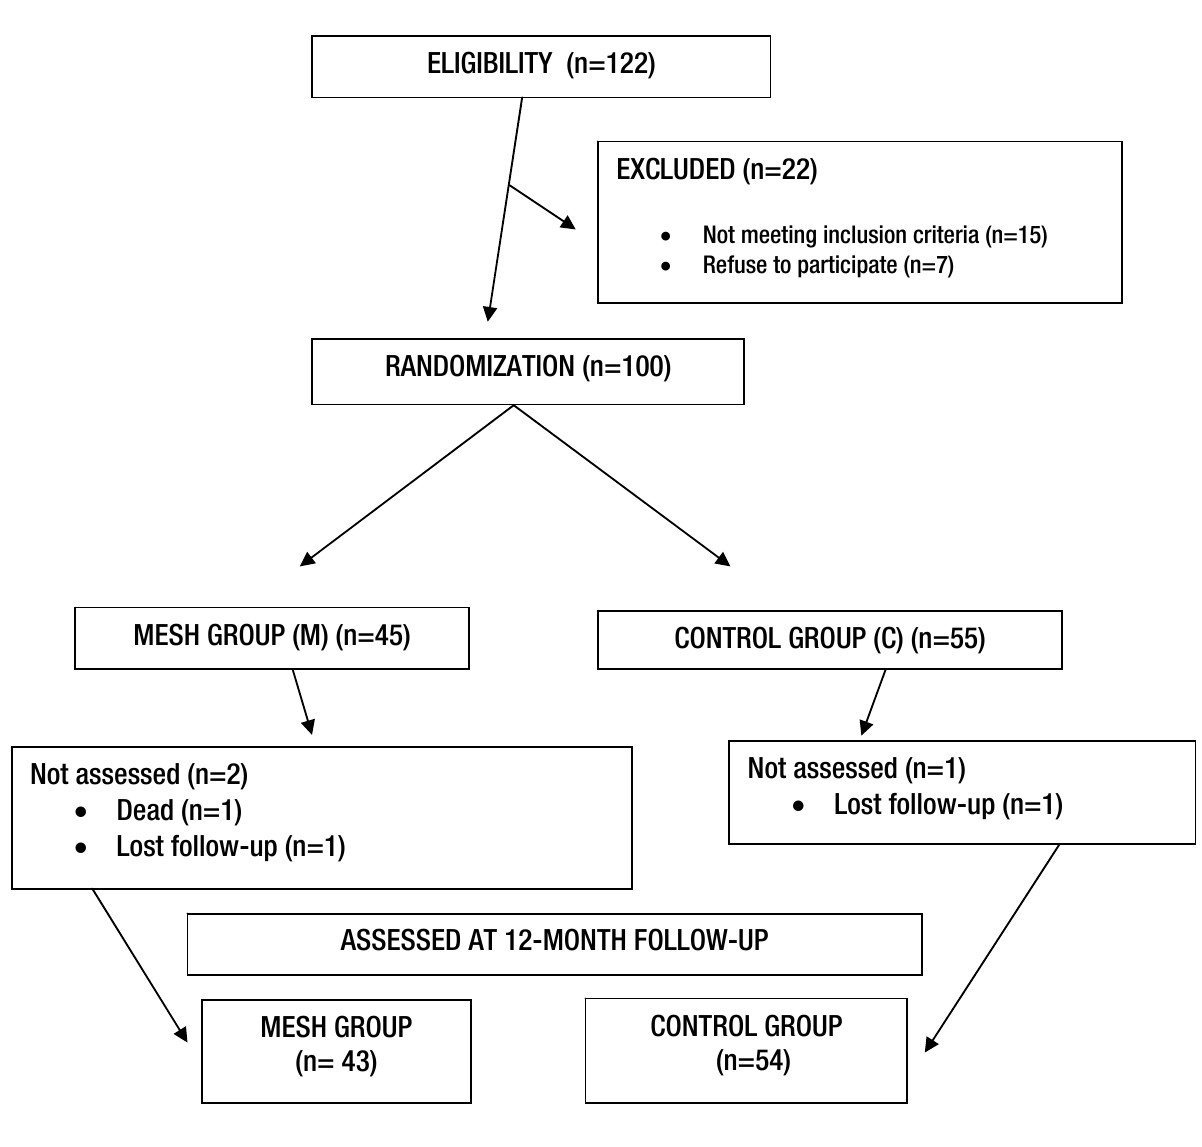
Figure 1 – Patient flow and